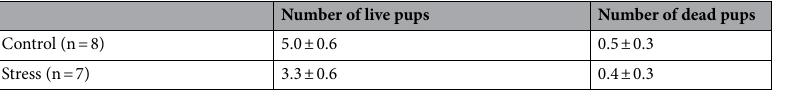
Table 1. The number of live or dead pups. Data are shown as the mean ± standard error. There was no significant difference between the two groups.